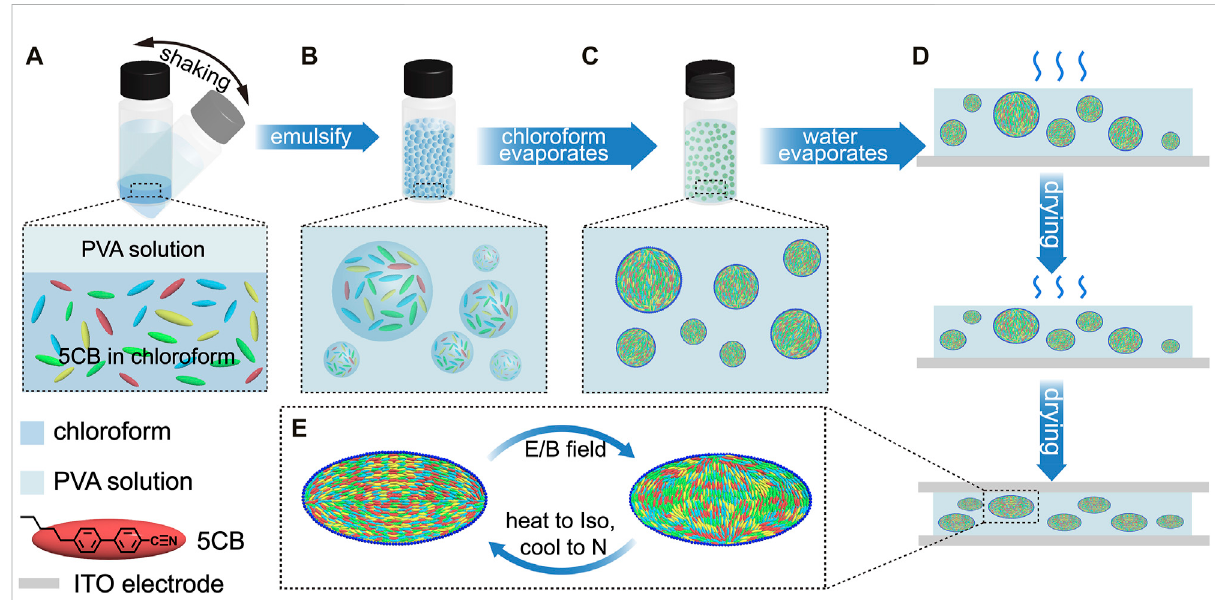
FIGURE 1 Electro-optic response of 5CB bipolar nematic con fi ned in oblate spheroids under planar anchoring. (A) and (B) 5CB is fi rst dissolved in chloroform and emulsi fi ed in the PVA solution. (C) As chloroform evaporates, 5CB nematic spheres adopt a bipolar director con fi guration under the planar alignment imposed by PVA. (D) When the spherical droplets are squeezed into oblate spheroids under the shrinkage force of the drying PVA fi lm, the bipolar axis is con fi ned in the horizontal plane to reduce elastic distortion. (E) Under a threshold E or B fi eld, the bipolar structure reorients to the vertical con fi guration and is trapped there when the external fi eld is removed. The vertical con fi guration could relax to the low- energy horizontal con fi guration through a temperature cycle of N-Iso-N phase